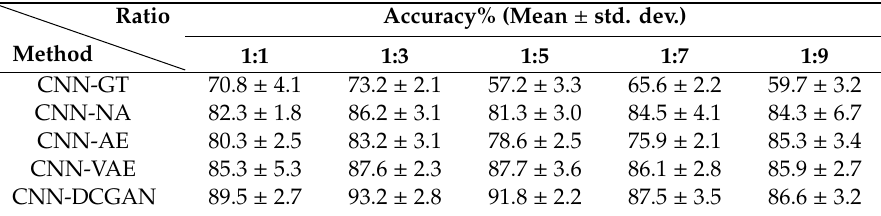
Table 7. Classification Accuracy of the methods for the BCI competition IV dataset 2b (baseline: 80.6 ± 3.2%).